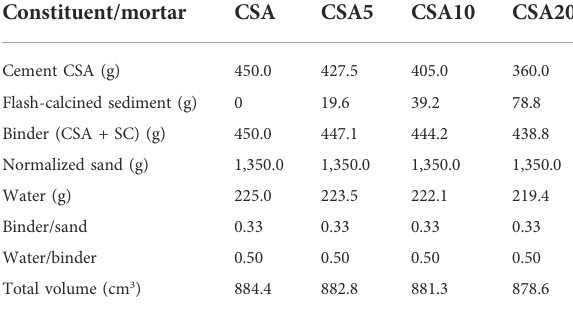
TABLE 1 Mortar composition of CSA, CSA5, CSA10, and